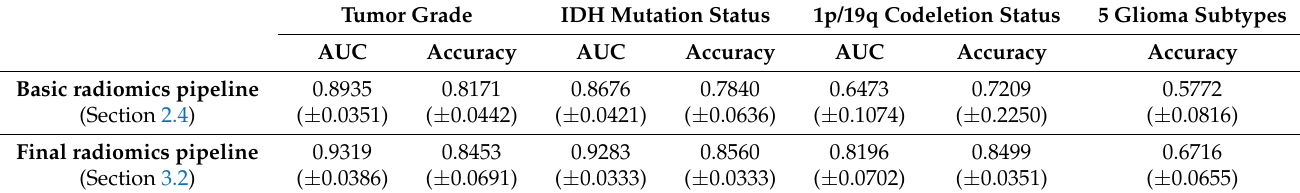
Table 3. Summary of the prediction performance on the hold-out test data before the pipeline tuning (basic radiomics pipeline) and after the pipeline tuning (final radiomics pipeline). The mean and standard deviation (in brackets) AUC/accuracy averaged on the 51 random seeds are reported, regarding different tumor grades, IDH mutation status, 1p/19q codeletion status, and the glioma subtypes. Note that, when reporting the accuracy, the threshold that maximizes the F1-score of the train data were chosen as the final threshold for each binary classification